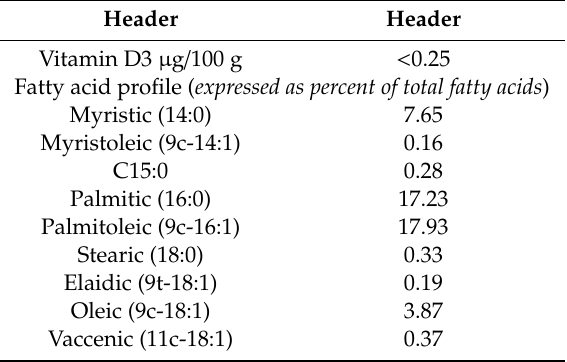
Table 3. Fatty acid composition of NG